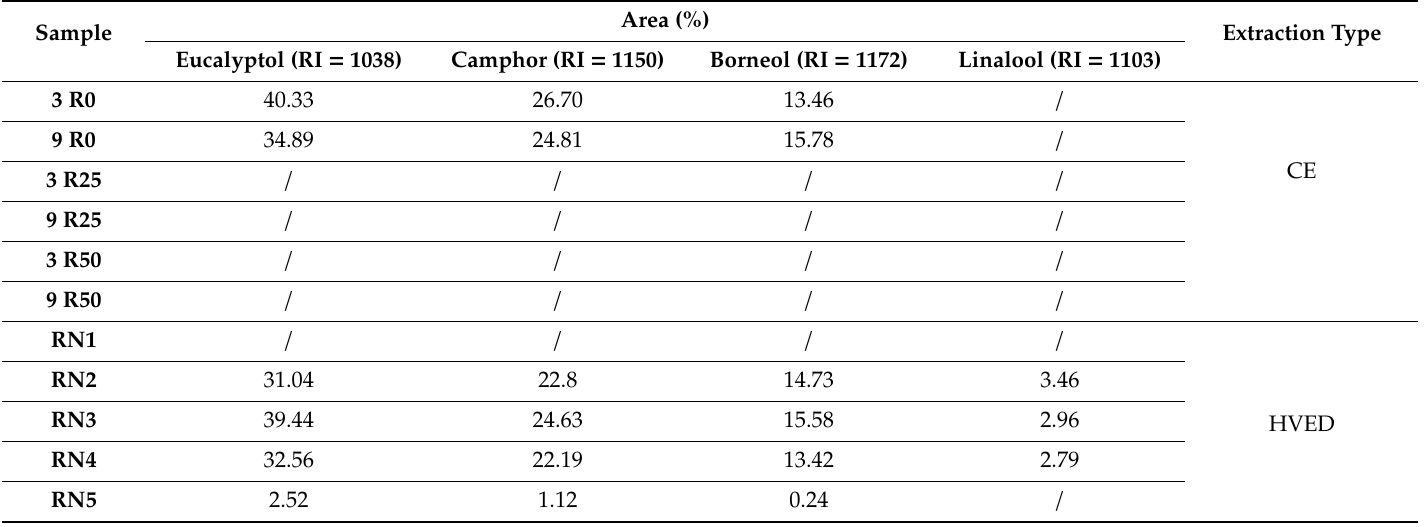
Table 6. Headspace solid-phase microextraction / gas chromatography-mass spectrometry (HS–SPME / GC–MS) analysis of volatile compounds from rosemary (measurements for CE and HVED treated samples)